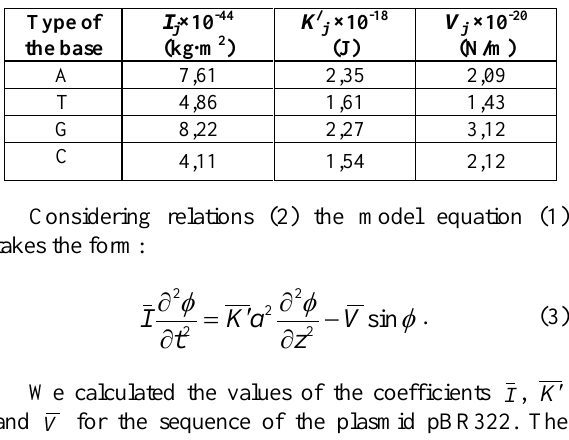
Table 1 . Coefficients of equations (2) [18].